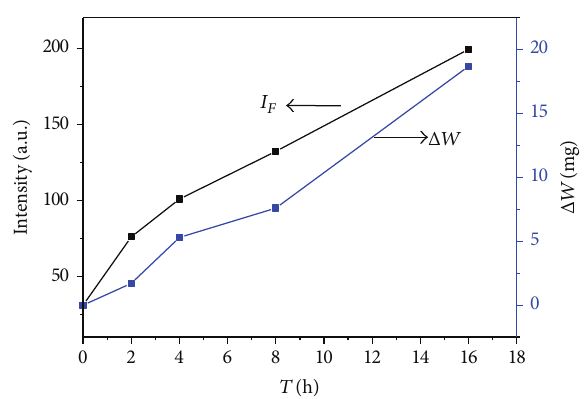
Figure5:Variationofweight-loss( Δ𝑊 )andfluorescenceintensities ( 𝐼 𝐹 ) for T91 steels in 3% NaCl